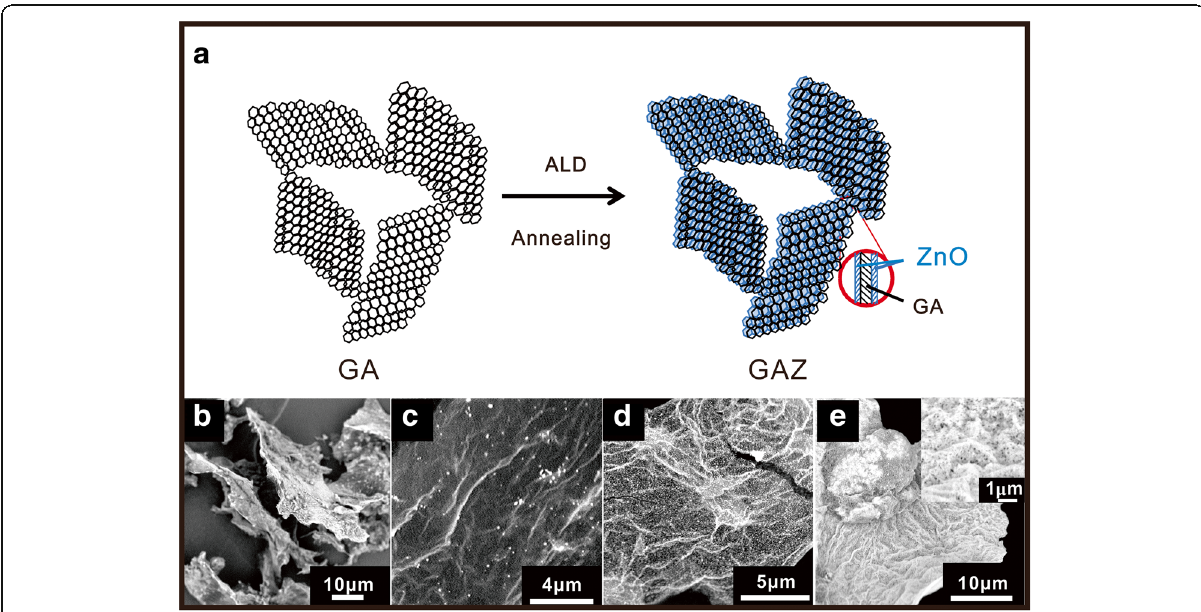
Fig. 1 a Fabrication schematic of GAZ composites. SEM images of b GA, c GAZ20, d GAZ100, and e GAZ300. The inset in e is enlarged SEM image of